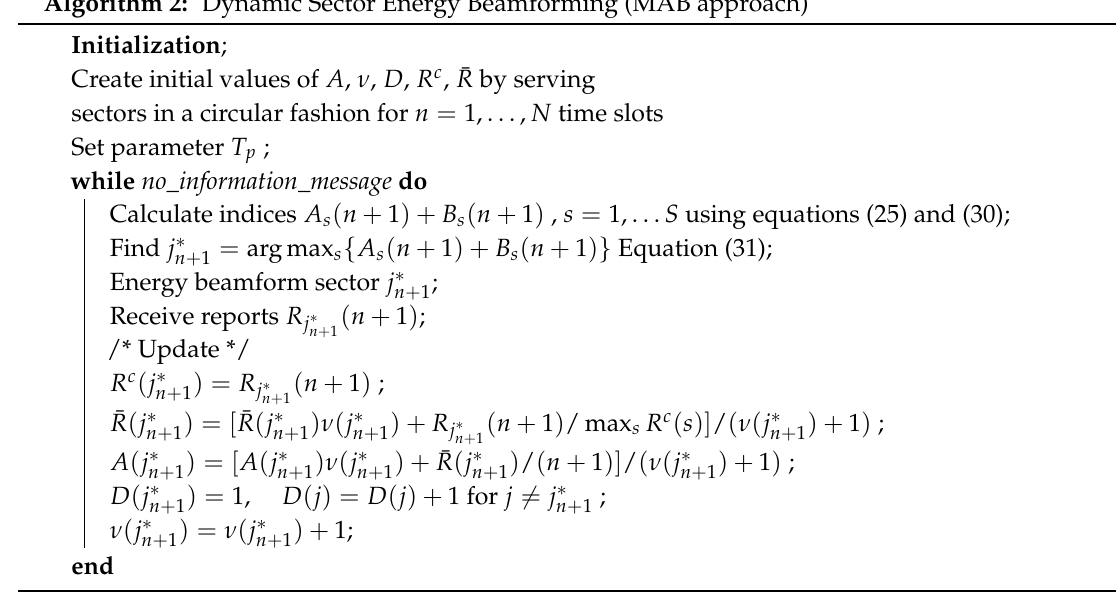
Algorithm 2: Dynamic Sector Energy Beamforming (MAB